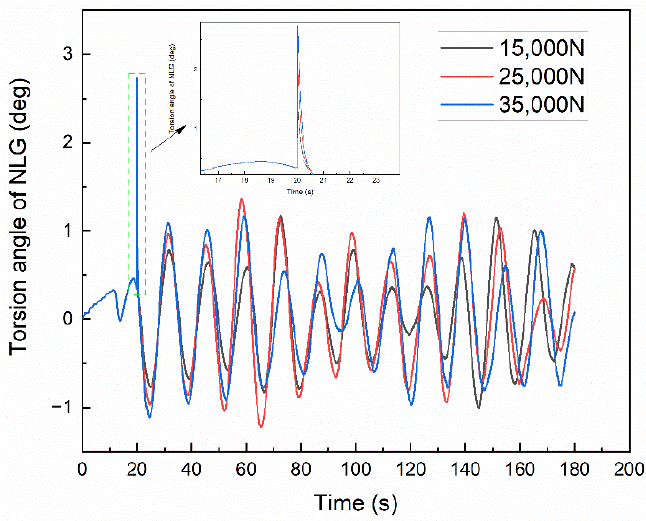
Figure 9. Effect of initial excitation on Torsion angle of NLG.